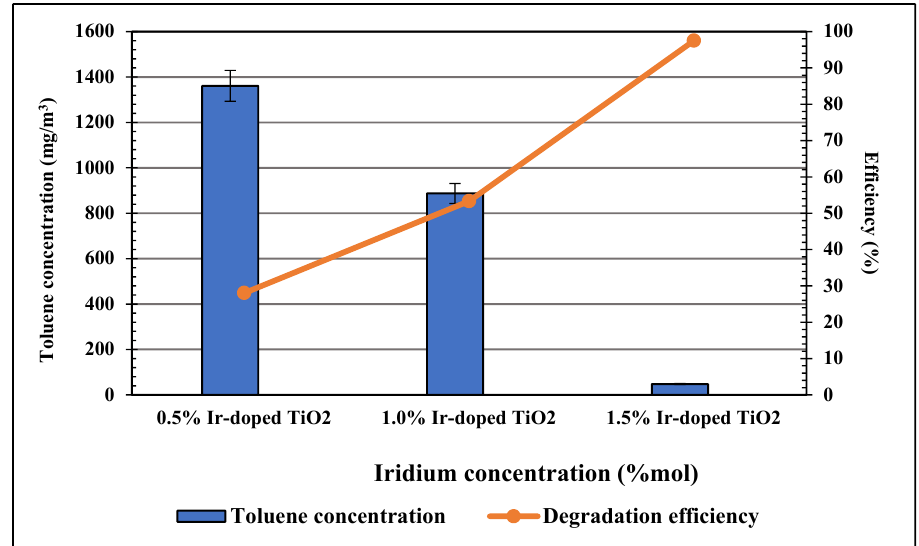
Figure 8. Effect of iridium’s mol fraction on photodegradation efficiency of toluene at 125 mL/min, φ = 70%.